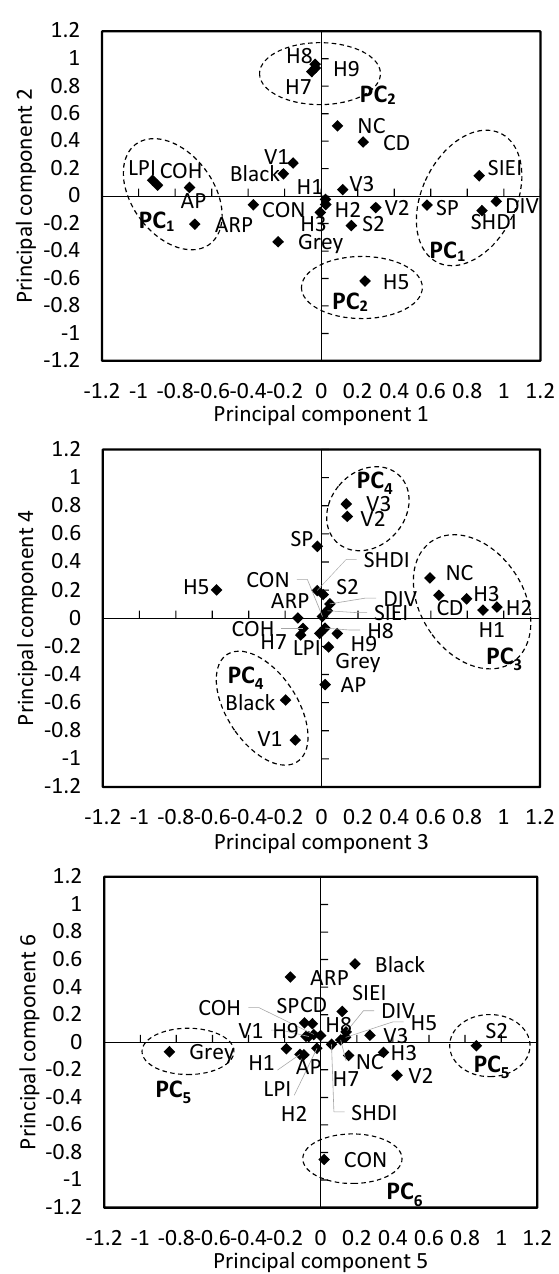
Figure 7. Principal component analysis of multiple color variables.